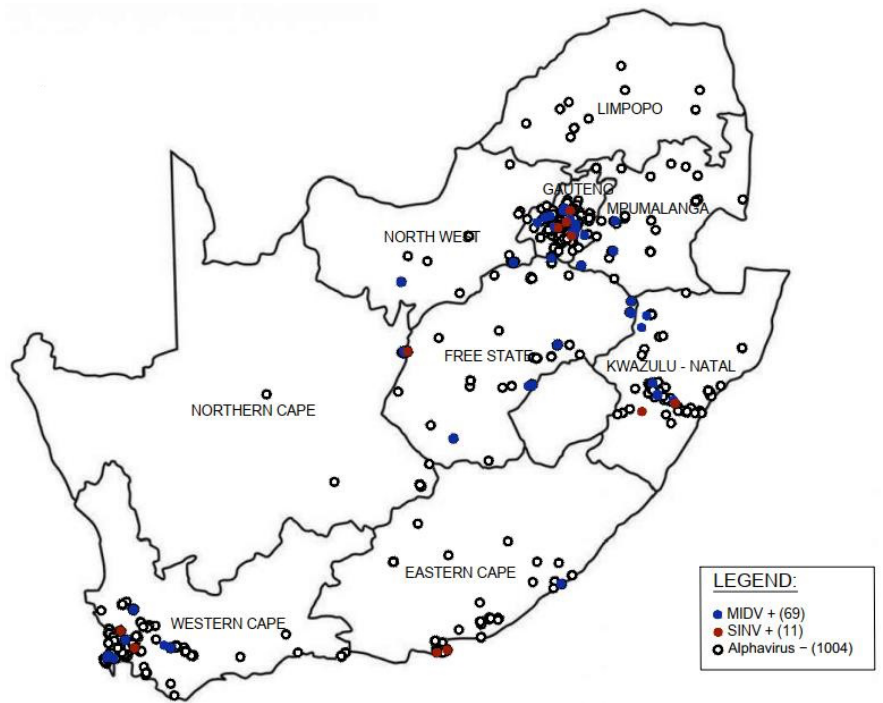
Figure 2. Map of Middelburg (MIDV)- and Sindbis virus (SINV) PCR positive infections reported in horses tested in South Africa from January 2014–December 2018. +: positive; − :